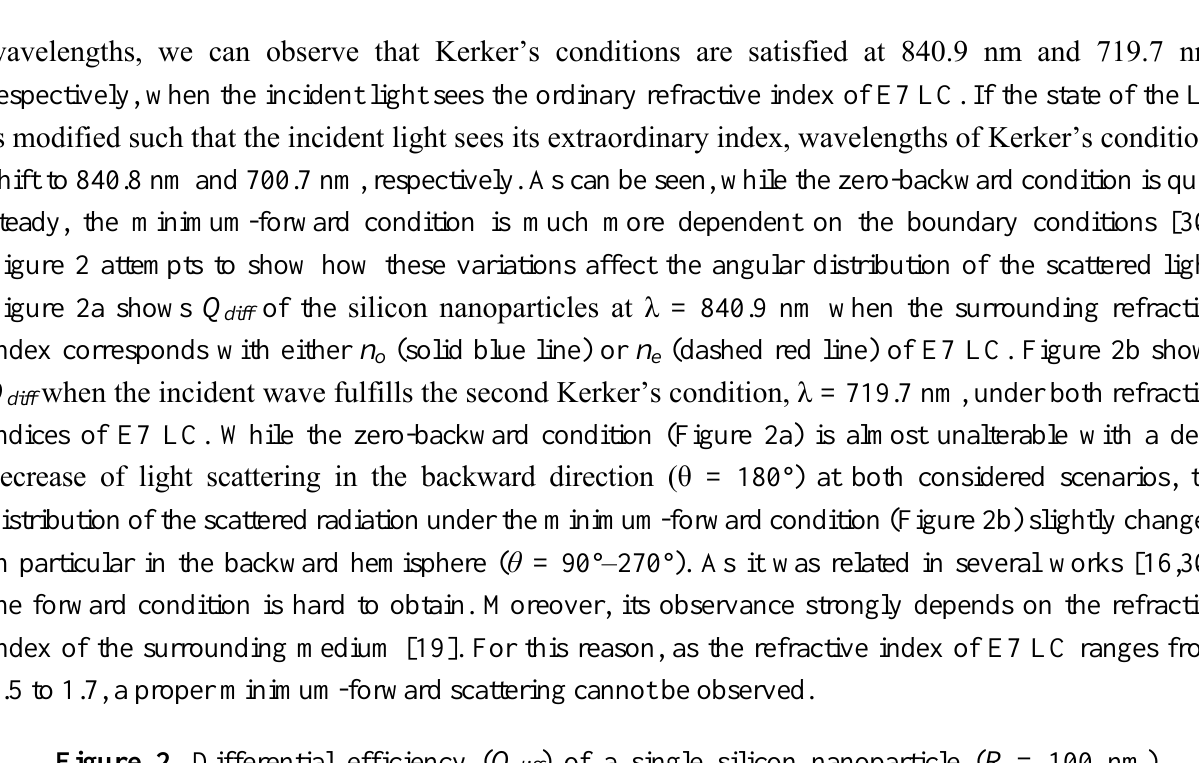
Figure 2. Differential efficiency ( Q ) of a single silicon nanoparticle ( R = 100 nm) diff embedded in an E7 nematic LC when the incident wavelength satisfies ( a ) the first Kerker’s condition and ( b ) the second Kerker’s condition. The ordinary (solid blue lines) and the extraordinary (dashed red line) index of E7 LC are